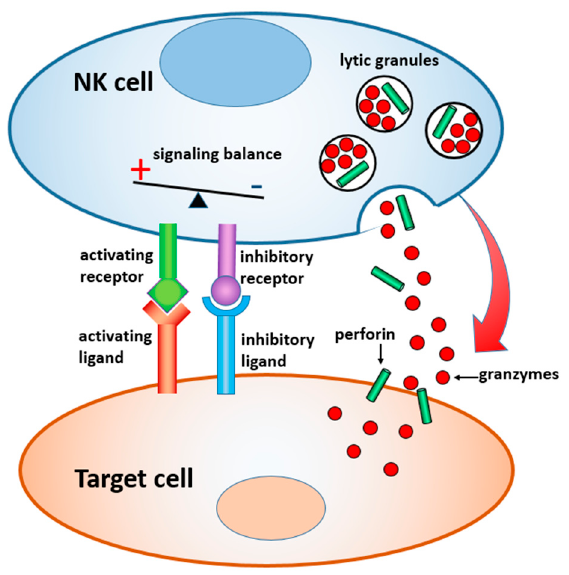
Figure 1. Scheme of the lytic immune synapse formed between a NK cell and a target cell. Degranulation is represented by the red arrow.